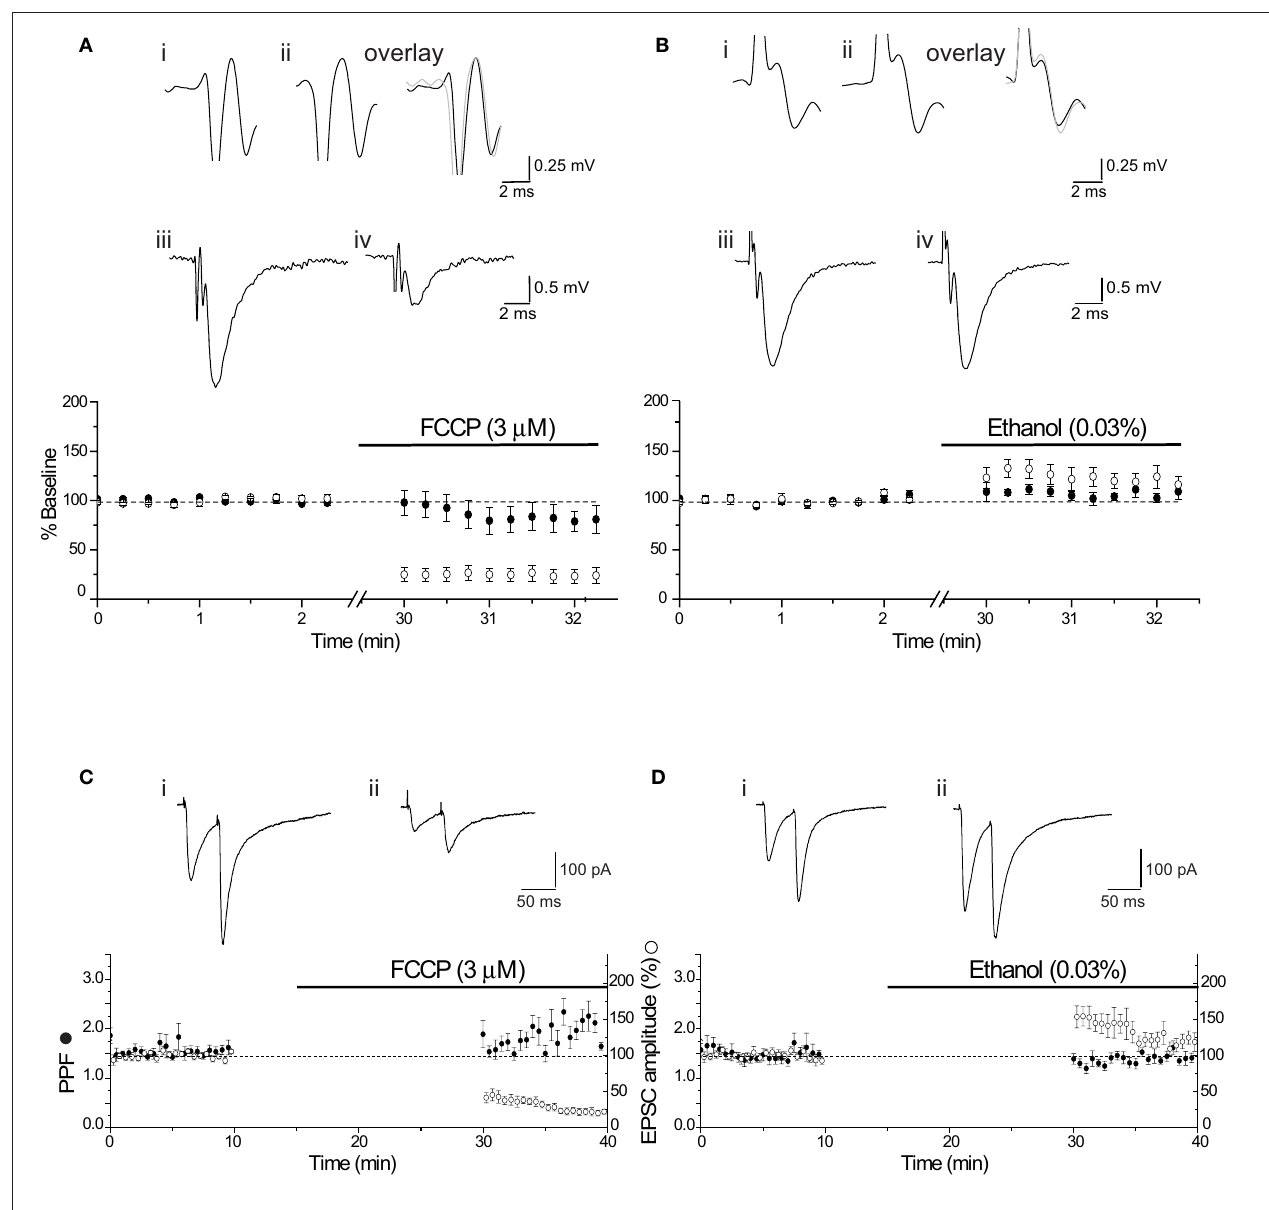
show the final baseline PFV (i), the first PFV evoked in ethanol (ii) and the overlay, and the control EPSP (iii) and in ethanol (iv). (C) FCCP (3 μM) had no significant effect on the first PPR, but reduced the EPSC by approximately 60%. Diary plot shows the effect of FCCP (3 μM) on PPR (•) and EPSC amplitude ( ○ ). Traces show the final baseline PPR (i) and the first PPR evoked in FCCP (3 μM) (ii). (D) The ethanol control had no effect on PPR (•), but augmented the EPSC amplitude ( ○ ) by approximately 50%. Traces show the final baseline PPR (i) and the first PPR in ethanol